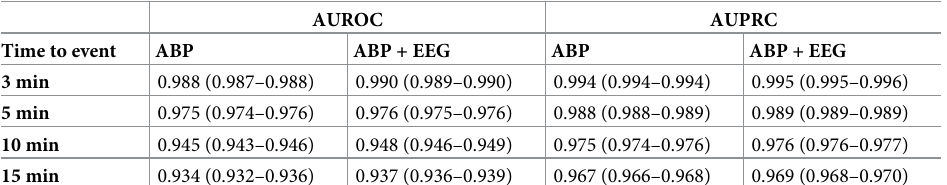
Table 4. Model performance metrics in post hoc analysis. AUROC, Area under the Receiver Operating Characteris- tic Curve; AUPRC, Area under the Precision-Recall